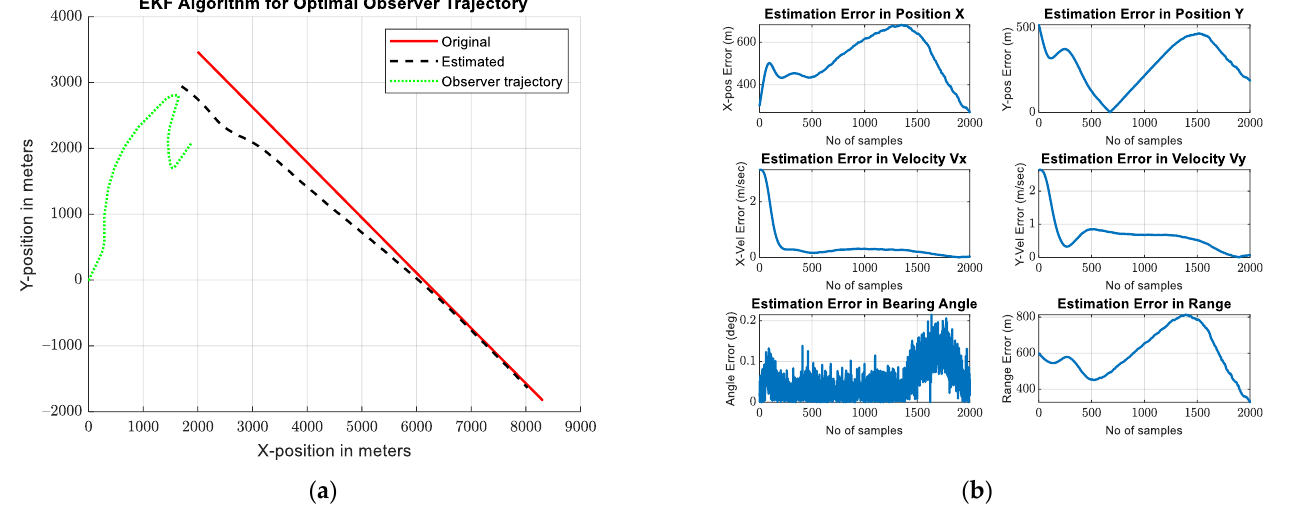
Figure 3. Simulation Results ( a ) Estimated Target Trajectory using EKF and; ( b ) Estimated Errors for Position, Velocity, Range, Bearing Angle for Optimal Observer path.